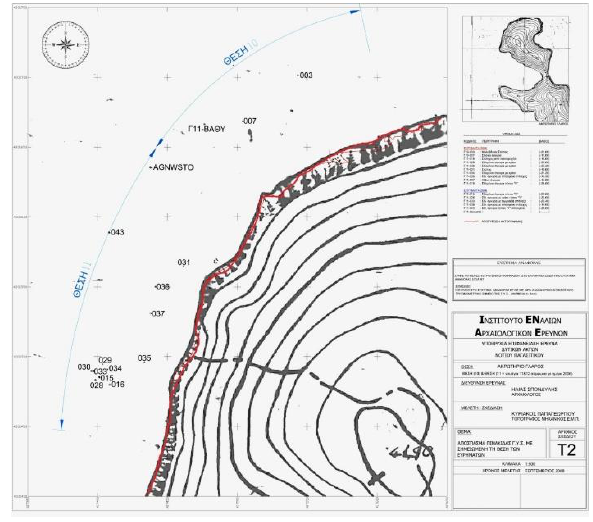
Figure 2: Preliminary work at Cape Glaros (©H.I.M.A.